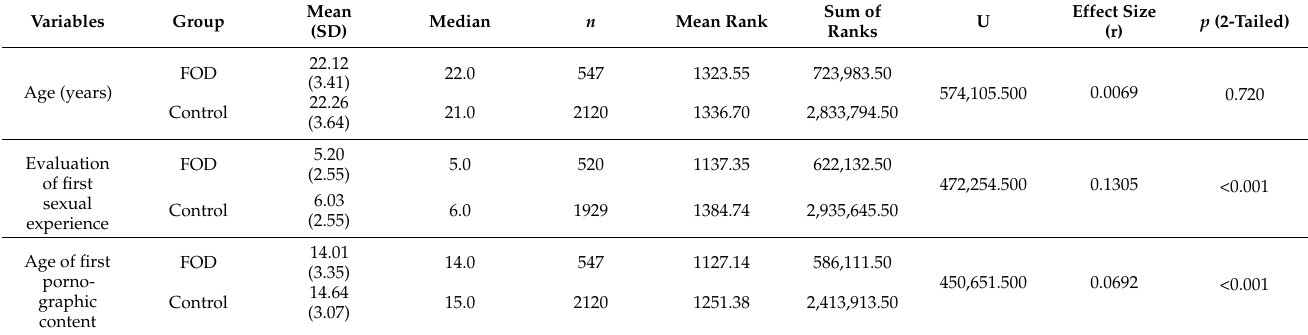
Table 2. Differences between the FOD group and control group in sexual experience, age of first pornographic content, and